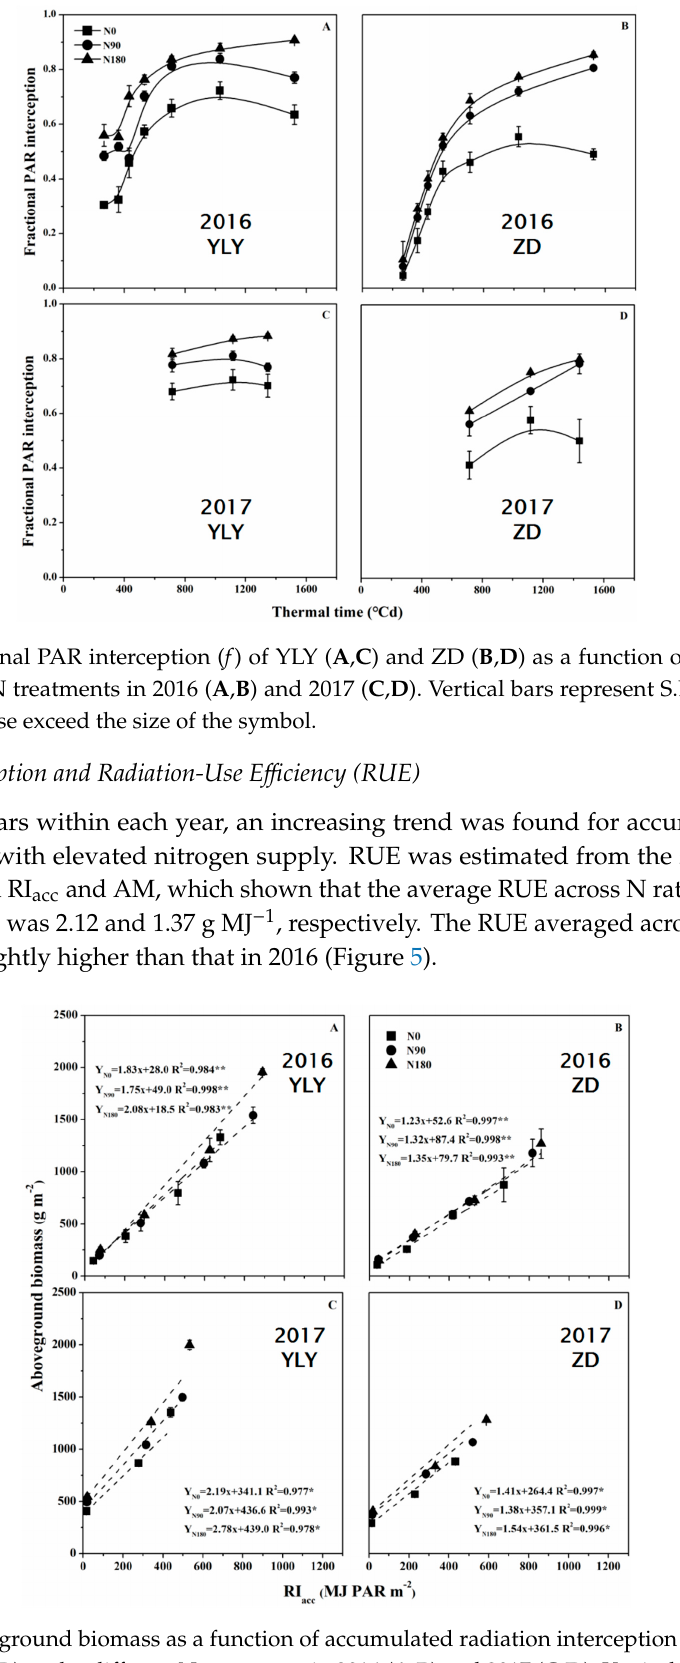
Figure 5. Above-ground biomass as a function of accumulated radiation interception (RI acc ) for YLY ( A , C ) and ZD ( B , D ) under di ff erent N treatments in 2016 ( A , B ) and 2017 ( C , D ). Vertical bars represents ( A,C ) and ZD ( B,D ) under different N treatments in 2016 ( A,B ) and 2017 ( C,D ). Vertical bars represents S.D. of the mean ( n = 3) where these exceed the size of the symbol. S.D. of the mean ( n = 3) where these exceed the size of the